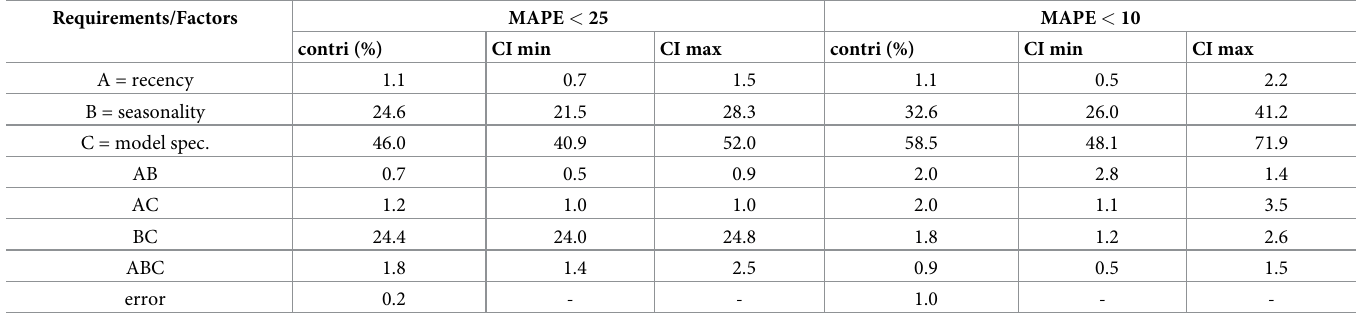
Table 17. Contribution of each of tourism prediction requirements: Recency, seasonality, model specialization and their interactions into the response variable in outdoor attractions (U.S. National Parks); results for MAPE < 10 and MAPE < 25 in 5 runs. Minimum and maximum confidence interval for 95% confidence are reported.